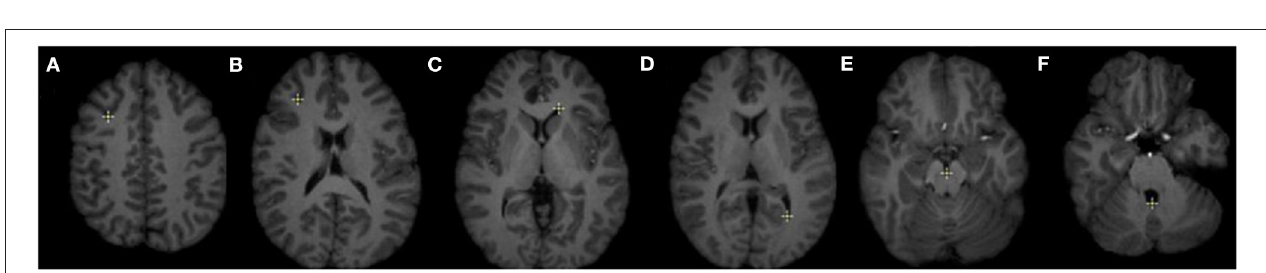
FIGURE 9 | Anatomical landmarks (A–F) used for quantitative evaluation of registration accuracy. A neurosurgeon located the landmarks. (A,B) cortex near tumor; (C) anterior horn of later ventricle; (D) triangular part of lateral ventricle; (E) junction between pons and mid-brain; (F) roof of fourth